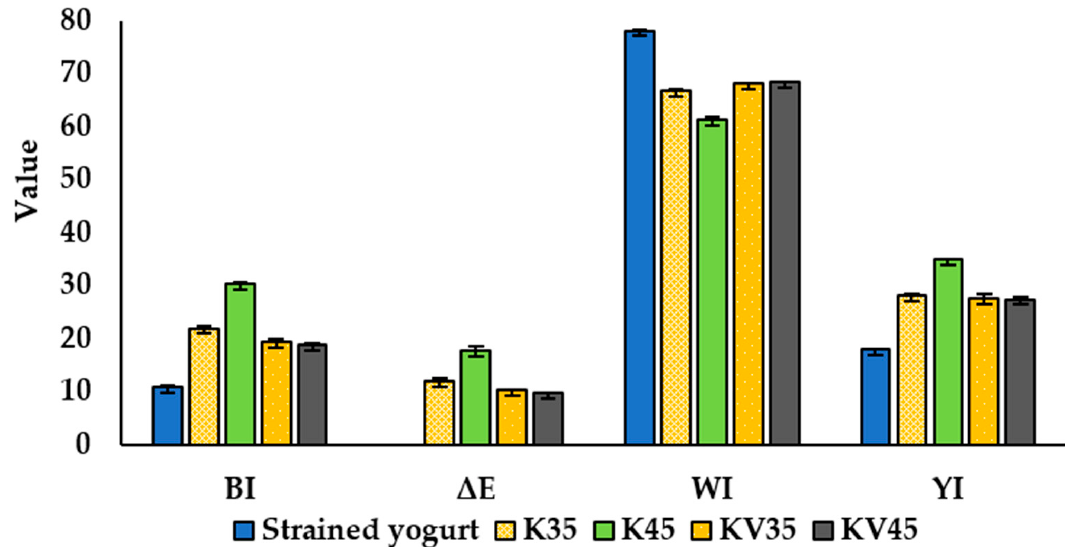
Figure 2. Derived color indices of strained yogurt and Kurut samples dried by VOD and OD techniques at 35 ◦ C and 45 ◦ C ( BI —Browning Index; ∆ E —Total color difference; WI —Whiteness Index; YI —Yellowness Index; Strained yogurt—raw material of Kurut samples, K35— Kurut sample OD applied at 35 ◦ C; K45— Kurut sample OD applied at 45 ◦ C; KV35— Kurut sample VOD applied at 35 ◦ C; KV45— Kurut sample VOD applied at 45 ◦ C (Means ± SD, n = 2)).